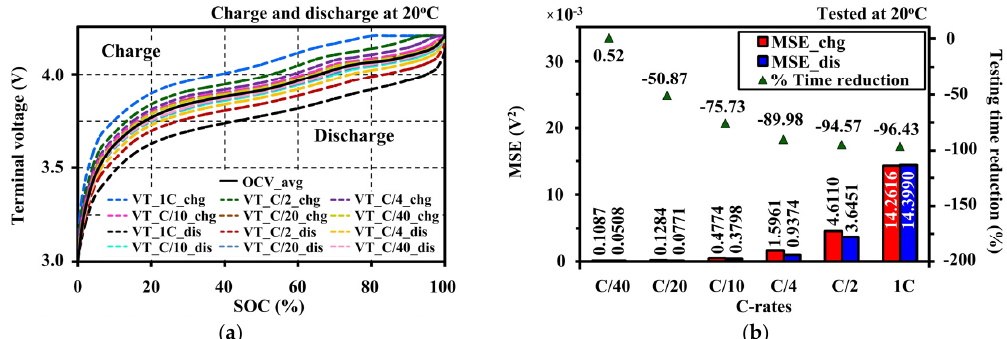
Figure 13. Terminal voltage relationship to the OCV approximation: ( a ) polarization differences of Figure 12. Effects of current amplitudes on the terminal voltage characteristic at 20 °C: ( a ) under terminal voltages under different rates of continuous testing current on the average OCV ; ( b ) mean of continuous charging; and ( b ) under continuous discharging. the squared residuals of the errors ( MSE ) and testing time reduction for OCV approximation under different rates of continuous testing current.